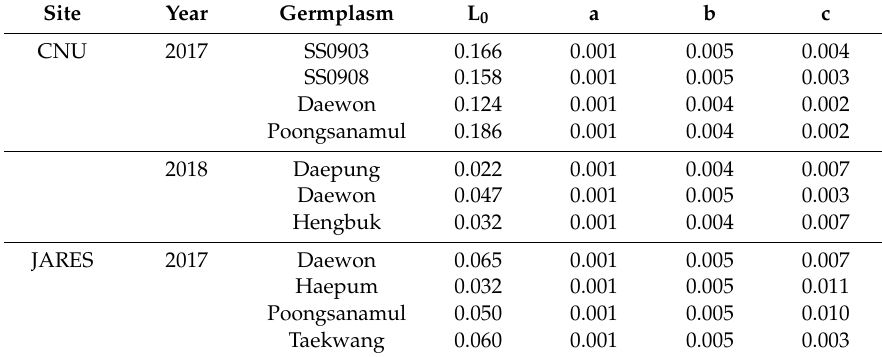
Table A1. Converged parameters of initial leaf area index (L 0 ) and leaf partitioning and senescence (a, b, and c) after the within-season calibration of the RSCM regime for germplasms or cultivars of soybean used in 2017 and 2018 at Chonnam National University (CNU), Gwangju and in 2017 at Jeonnam Agricultural Research and Extension Services (JARES) in Naju, Chonnam province, South Korea.